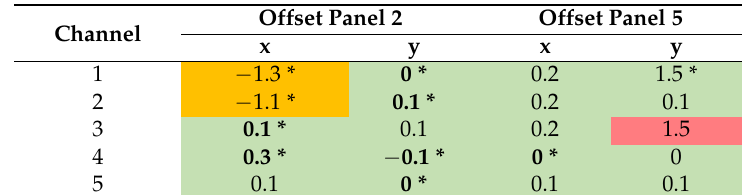
identifies a change and figures in bold type mark an improvement of the signal from the previous test.